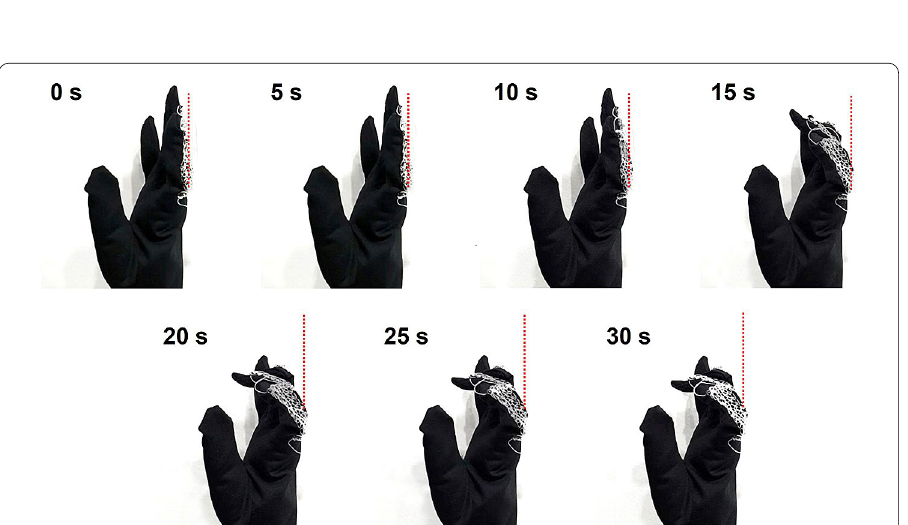
SD standard deviation